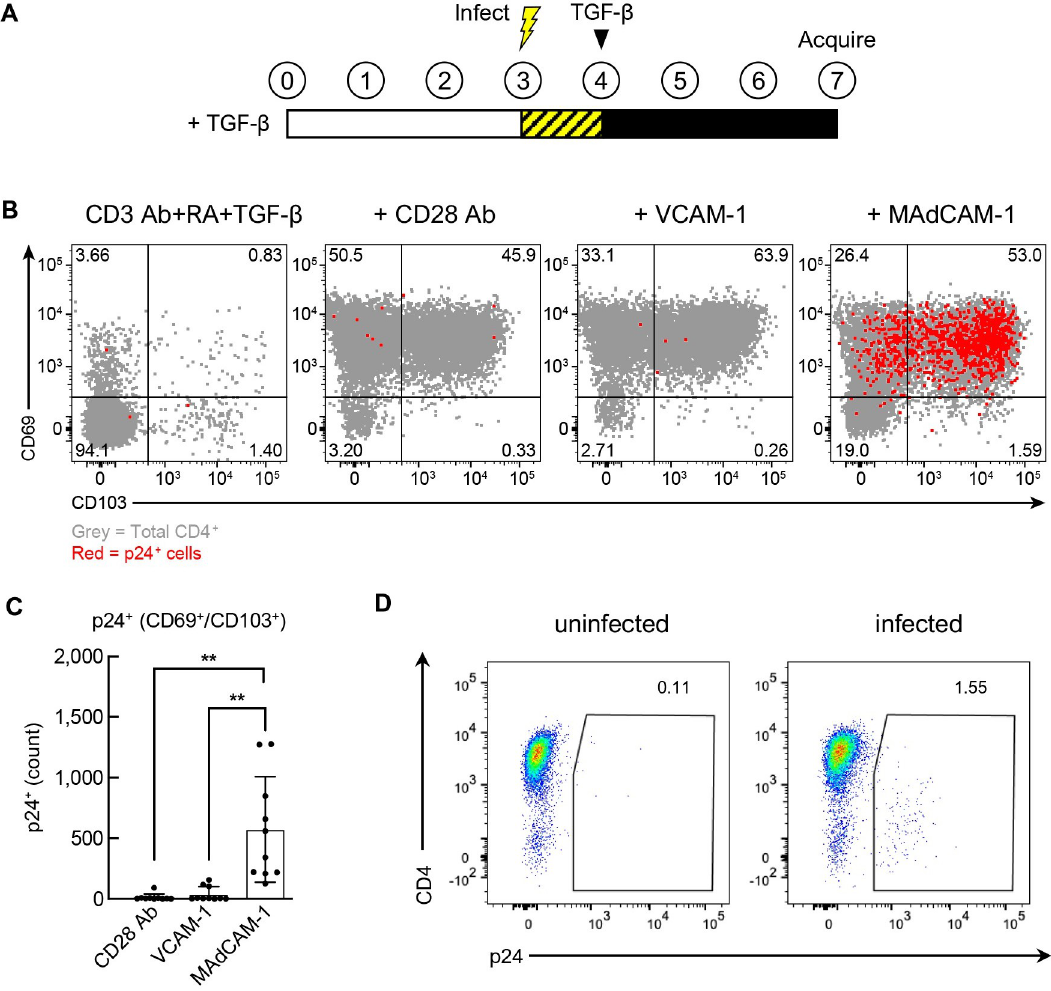
Fig 7. HIV infection following costimulation in the presence of RA and TGF- β . ( A ) Schematic of infection time course. ( B ) Representative flow cytometry dot plot indicating HIV infection of CD4 + T cells costimulated with CD28 Ab, VCAM-1 or MAdCAM-1 in the presence of RA and TGF- β (Y-axis: CD69, X-axis: CD103). p24 + cells shown in red. ( C ) Average number of p24 + cells in the CD69 + /CD103 + population of CD4 + T cells following costimulation as in B (n = 10). ( D ) Representative dot plot of CD4 downregulation in p24 + cells. X-axis: p24, Y-axis: CD4. ( �� : P < 0.01, two-tailed t test).